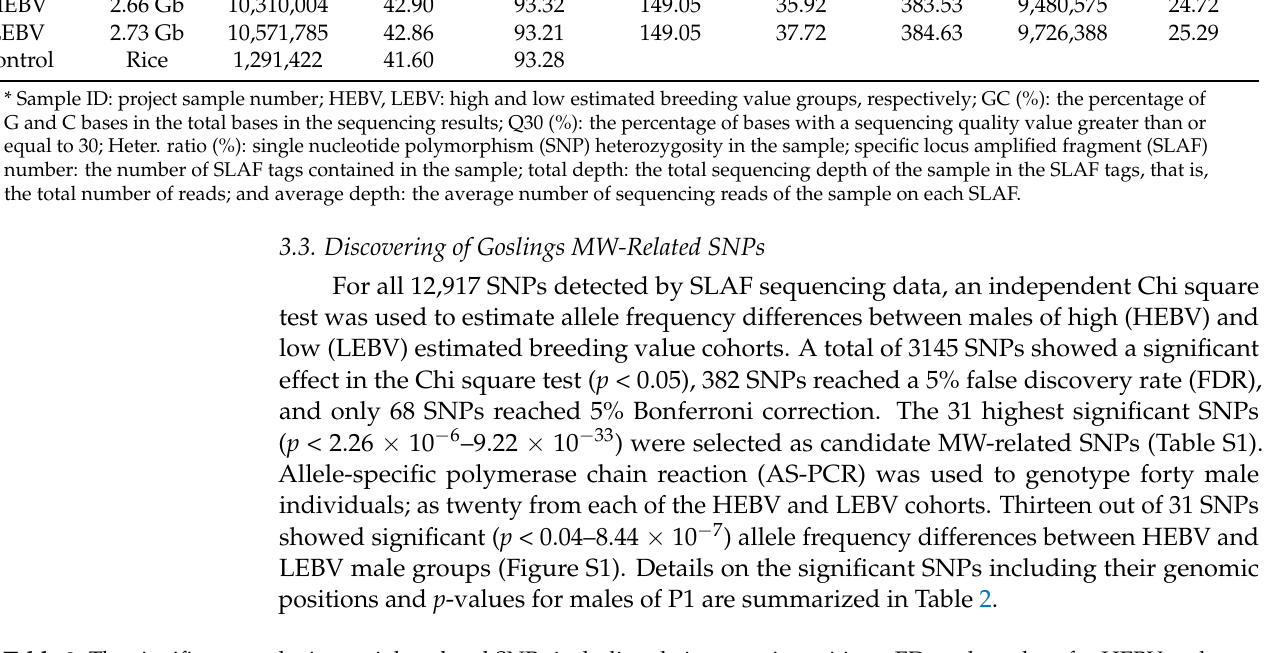
Table 2. The significant marketing weight-related SNPs including their genomic positions, ED, and p -values for HEBV and LEBV male and female goslings of first